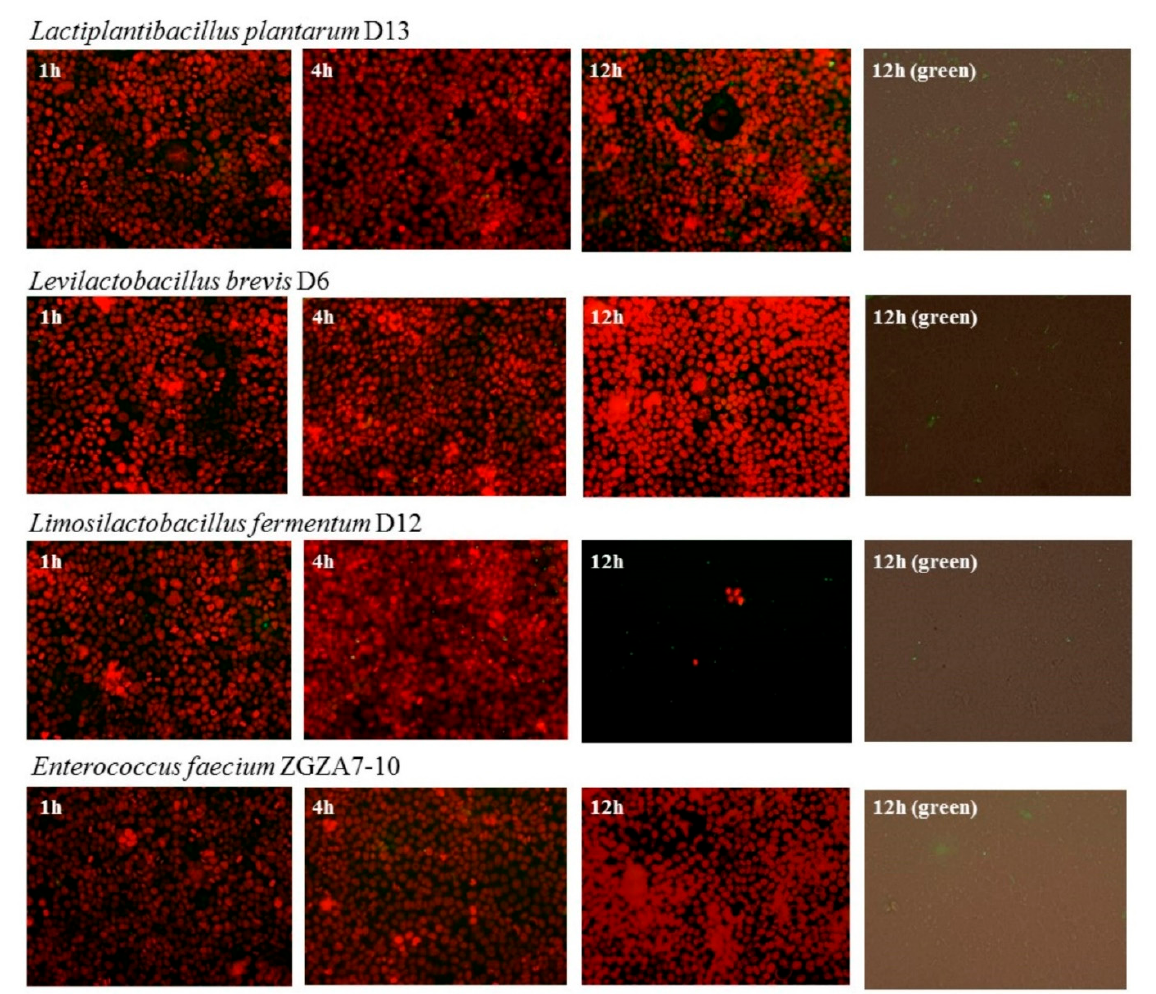
Figure 2. Fluorescence microscopy images of adhesion of individual strains of the LAB consortium to Caco-2 cell monolayer: D6, D12, D13 and ZGZA7-10 bacterial cells. Fluorescence overlays of Caco-2 cell nuclei (red fluorescence) with adhered LAB cells (green fluorescence) at a seeding density of multiplicity of infection (MOI) = 50, after 1, 4 and 12 h of incubation (overlay, and only green fluorescence) at 20× magnification.